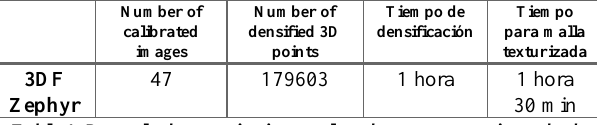
Figure 3. Sparse point cloud. (a) Photogrammetry, (b) Videogrammetry with sequence, (c) Videogrammetry